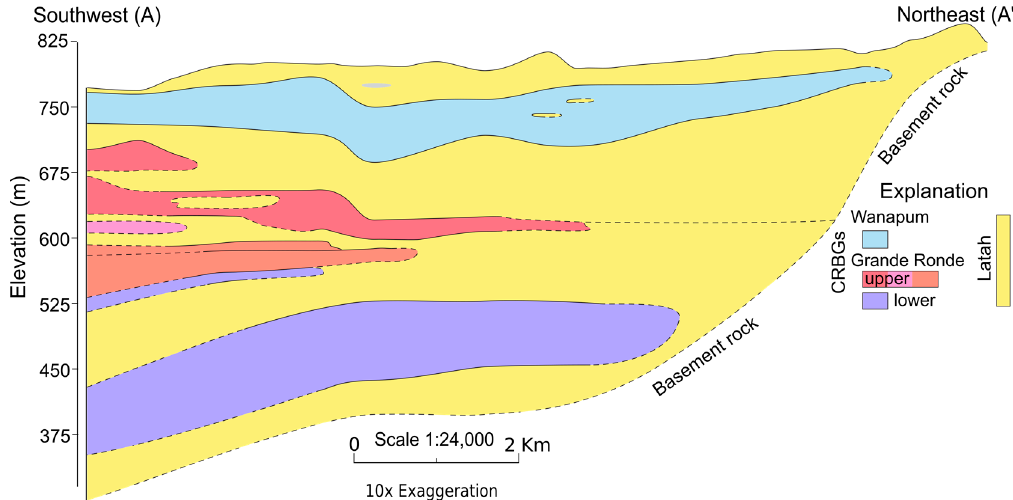
Figure 2. West-to-east cross section of the eastern South Fork Palouse River Basin that includes Pullman, Washington, and Moscow, Idaho (modified from Bush et al., 2018 [45]). Transect A–A’ is shown in Figure 1. CRBGs indicates the Columbia River Basalt Group formations.